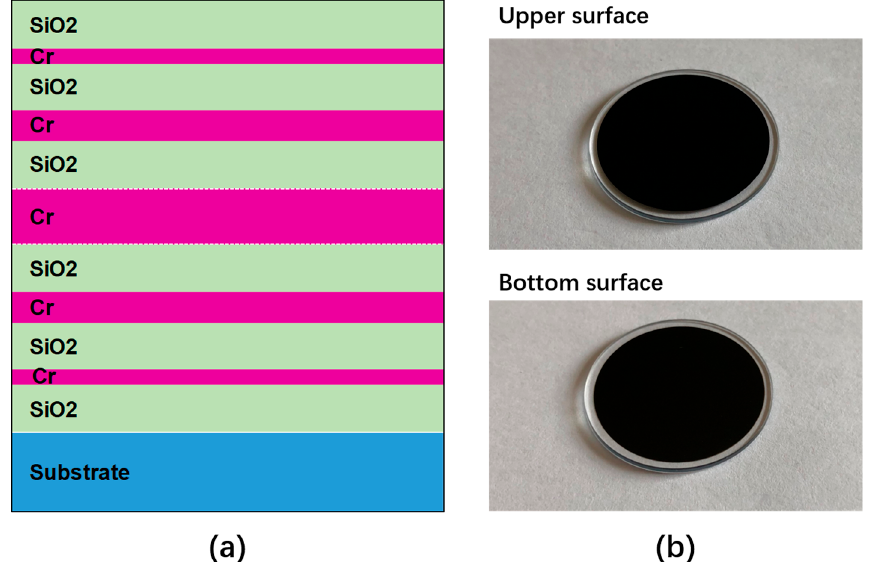
Figure 6. ( a ) The optimized absorber diagram with double symmetric structures; ( b ) both upper and bottom surface image of the optimized absorber.